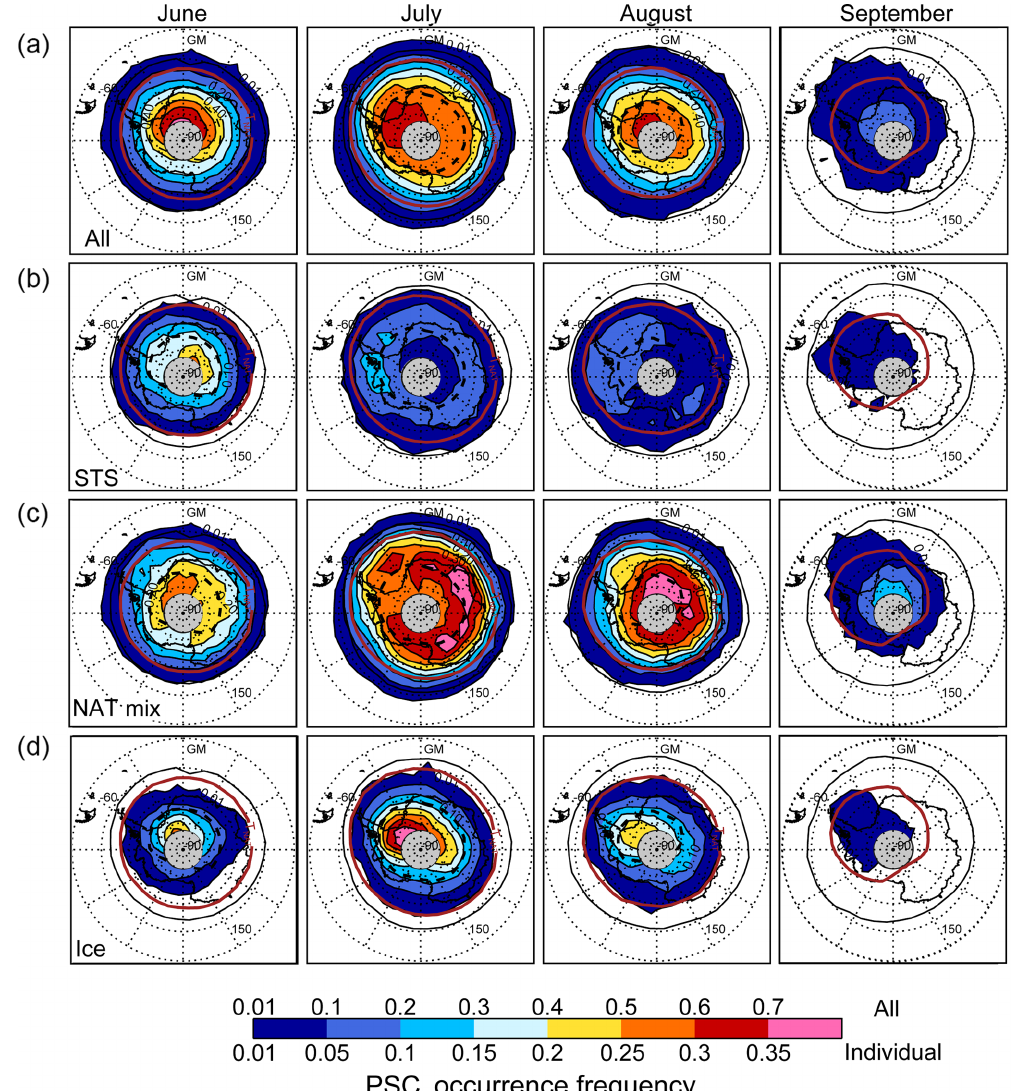
Figure 19. Twelve-year average, monthly mean polar maps of Antarctic PSC occurrence frequency at θ = 500K ( ∼ 20km). The top row shows the occurrence frequency for all PSCs, while the subsequent rows display the occurrence frequencies of STS, NAT mixtures (including enhanced NAT), and ice (including wave ice). Overlaid in the panels are the mean location of the edge of the vortex (black line) and the boundaries of the regions where the mean temperature is below T NAT (solid red line) and below T ice (dashed black line). Light gray regions indicate latitudes not sampled by CALIOP. Note the different color scales for “all” PSCs and “individual”